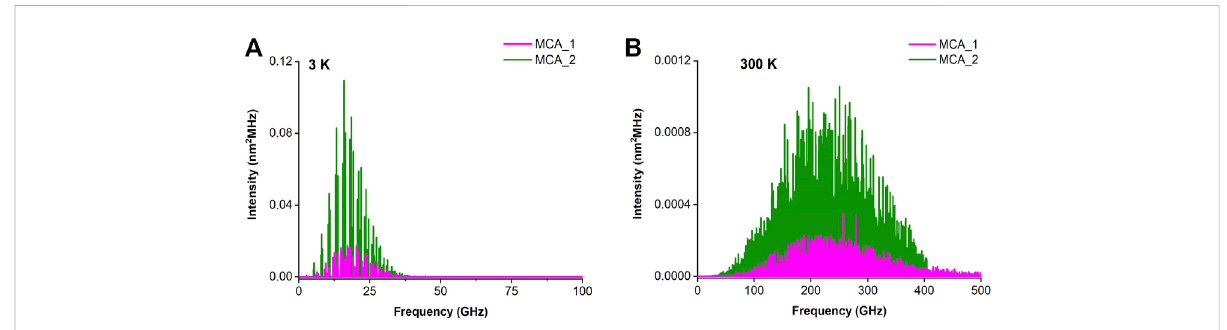
FIGURE 4 The distribution of the rotational transitions of MCA_1 (magenta) and MCA_2 (green) at 3 K (left, panel (A) ) and at 300 K (right, panel (B) ). The spectra were simulated up to 500 GHz and J quantum numbers up to 100. The plot was made for the case of 2 I +1 = 1, considering only a -type transitions. Note the different intensity scales for the two panels.